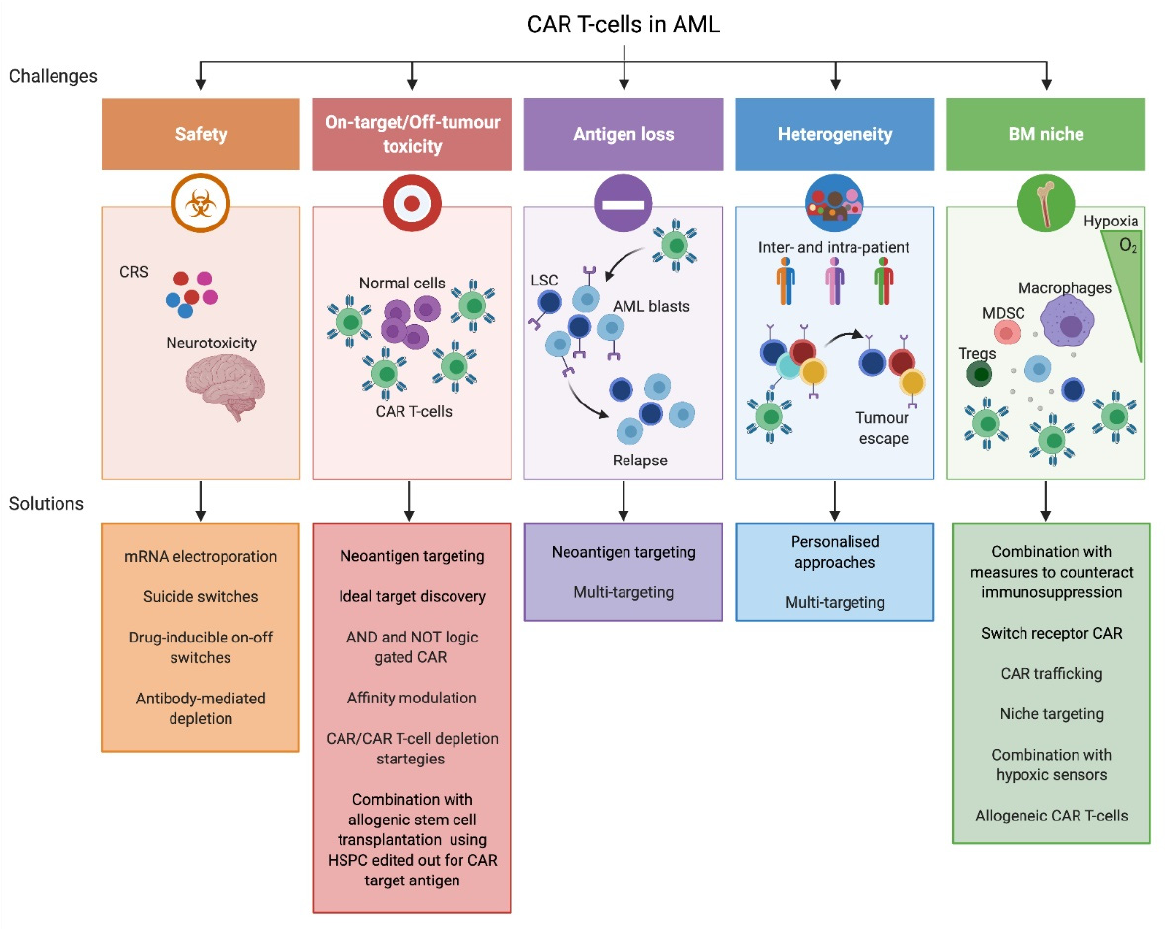
Figure 2. Schematization of chimeric antigen receptor (CAR) T-cell limitations in acute myeloid leukemia (AML) therapy and possible strategies to overcome them. Cytokine release syndrome (CRS) and neurotoxicity are the most frightening side effects related to the use of CAR T-cells in patients. Strategies to deplete CAR/CAR T-cells (e.g., mRNA electroporation of the CAR, suicide switches, drug-inducible on–off switches, and antibody-mediated depletion) could be employed to reduce the persistence of the toxicity. Due to the absence of an ideal target in AML, CAR T-cells impact normal cells expressing the target antigen. Thus, it is essential to identify suitable neoantigens and novel potential targets (leukemia- specific). To overcome on-target/off-tumor toxicity, AND- and NOT-logic-gated CAR can be employed to increase